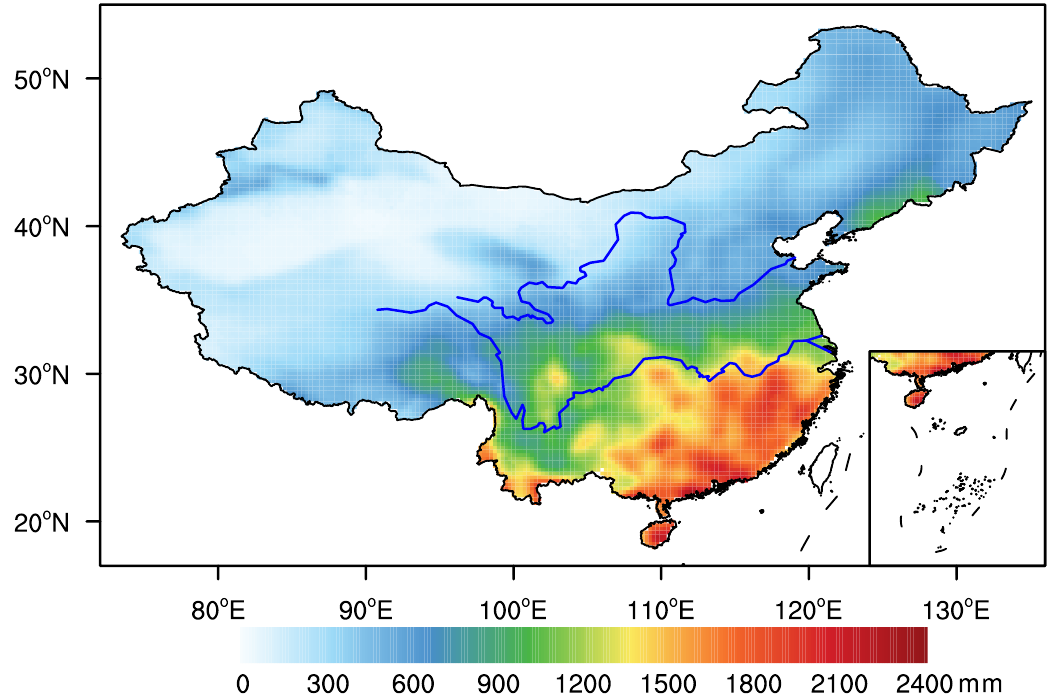
Figure 2. Mean annual precipitation (MAP) distribution in China during the period of